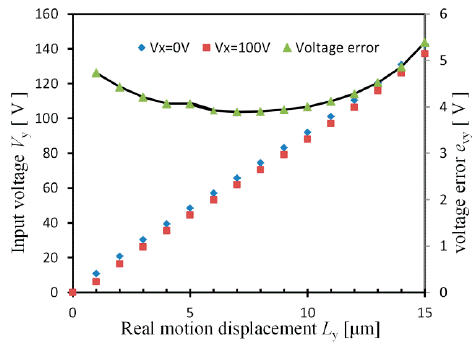
Figure 12. Relationship between the real motion displacement L y and the needed input voltage V y .